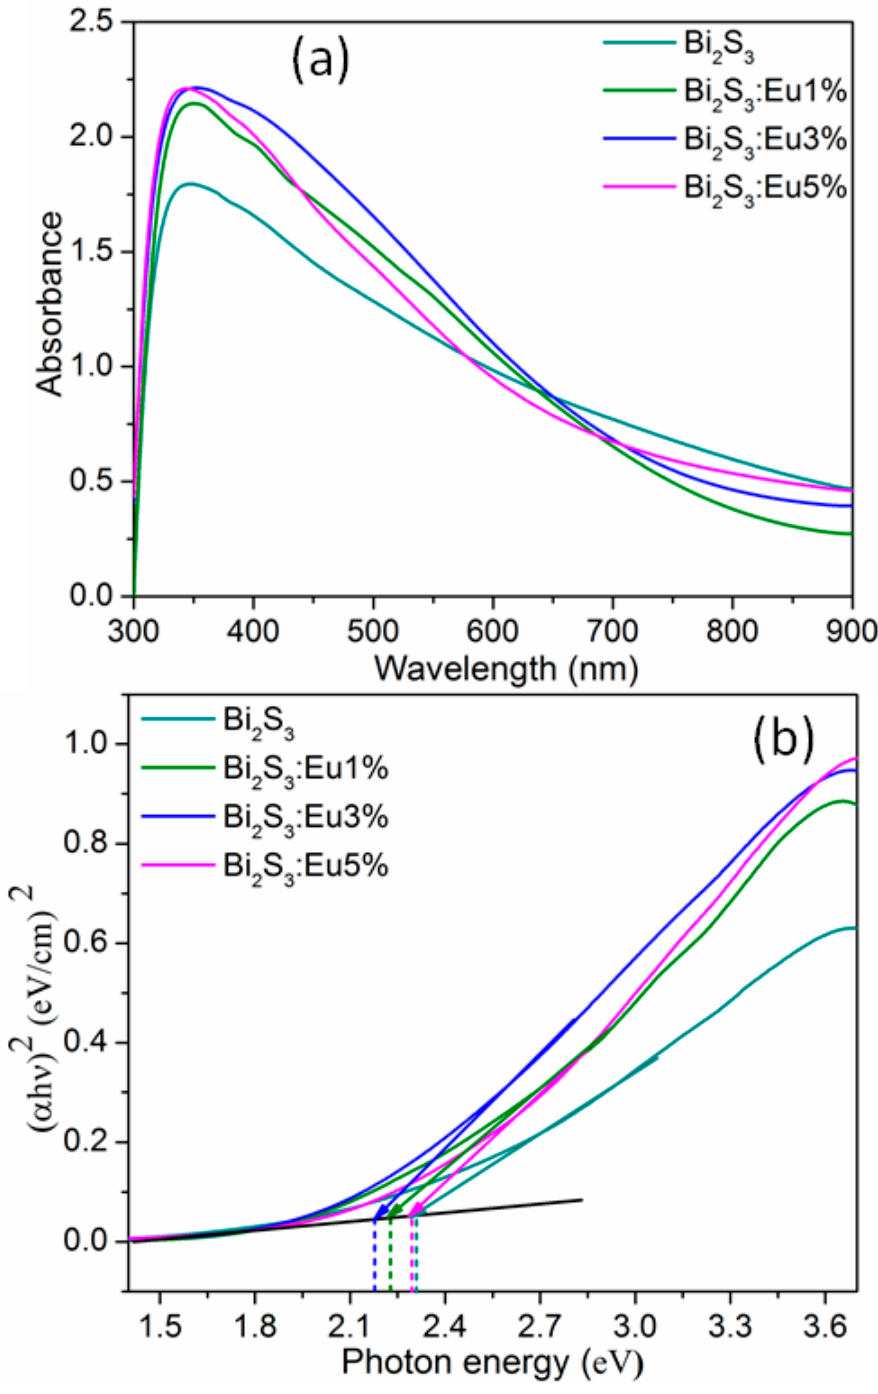
Figure 5. ( a ) Absorption spectra and ( b ) Tauc plots of Eu-doped Bi 2 S 3 thin films with different Eu concentrations.